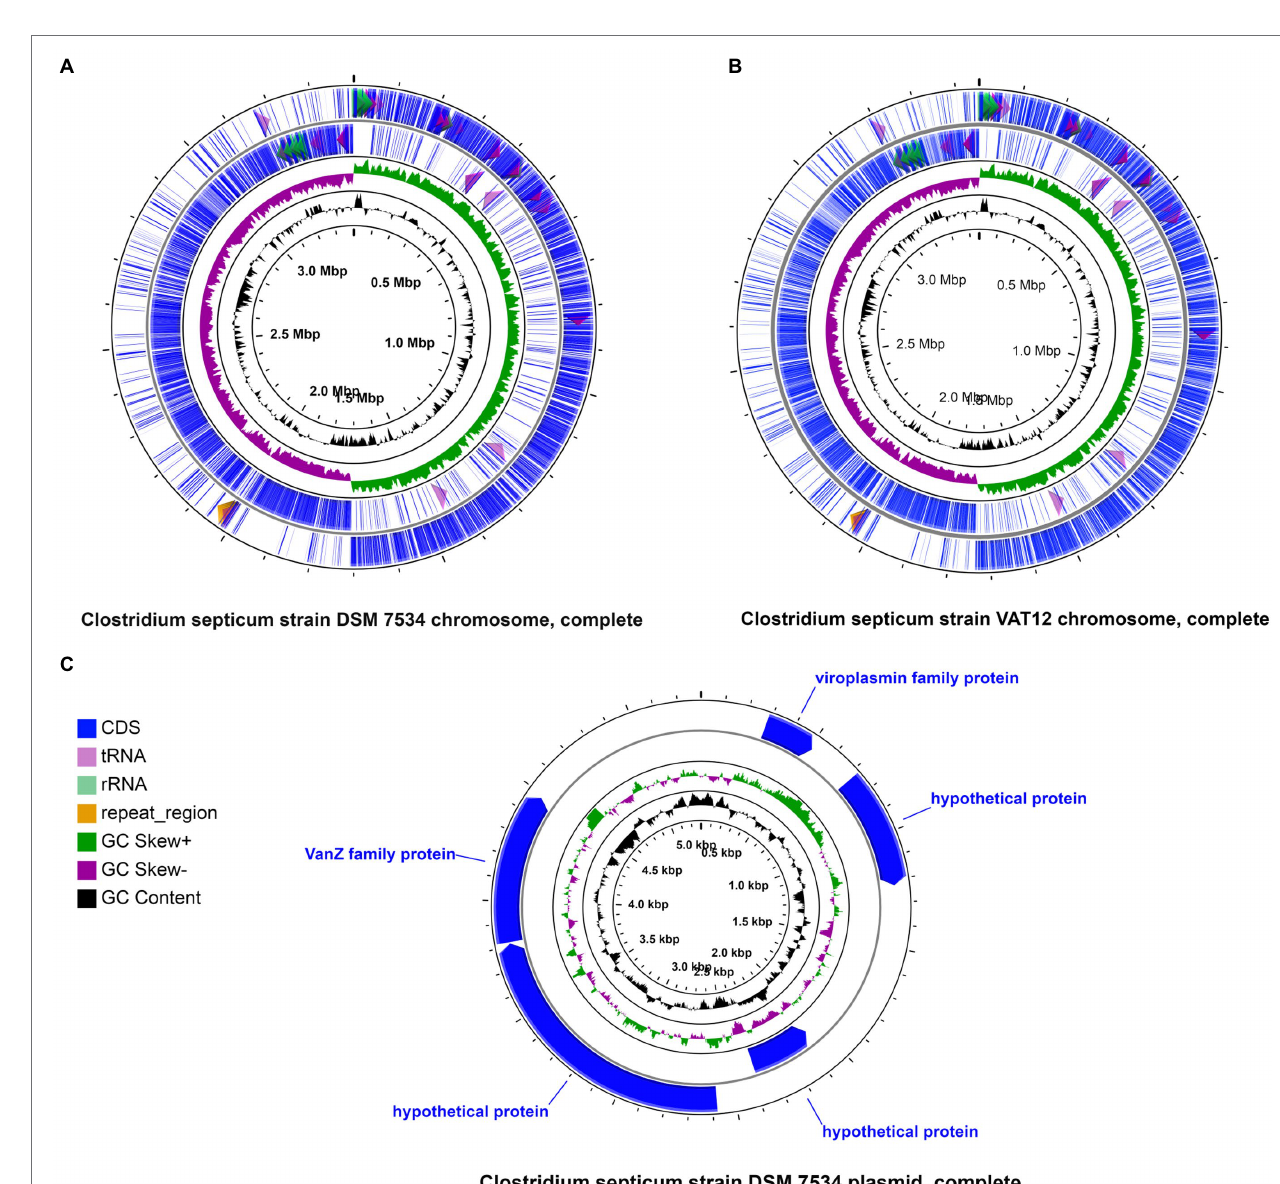
the isDDH value of C. septicum DSM 7534 T compared to C. chauvoei genomes (DSM 7528 T and JF4335) was 28.8. The GC content variability between the C. septicum genomes to the reference genome ranged from 0.09 to 0.35 whereas to C. ( Supplementary Table S2 ). Taken together, these results indicate a clear species delimitation of C. septicum and confirm the stable phylogenetic relationship of C. septicum with C. chauvoei . CRISPR Regions were separated by a gene-encoding for IS256 family